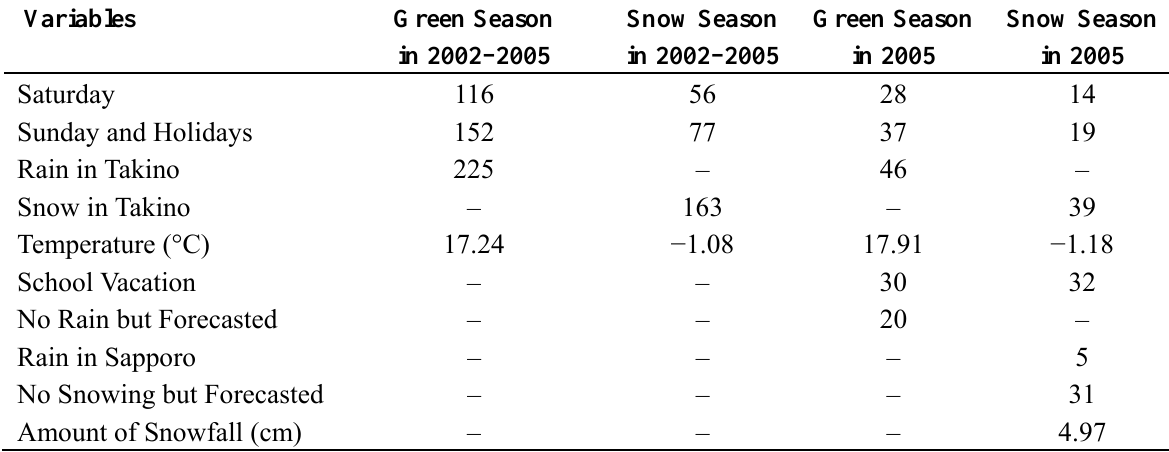
Table 1. List of variables, average and days for each